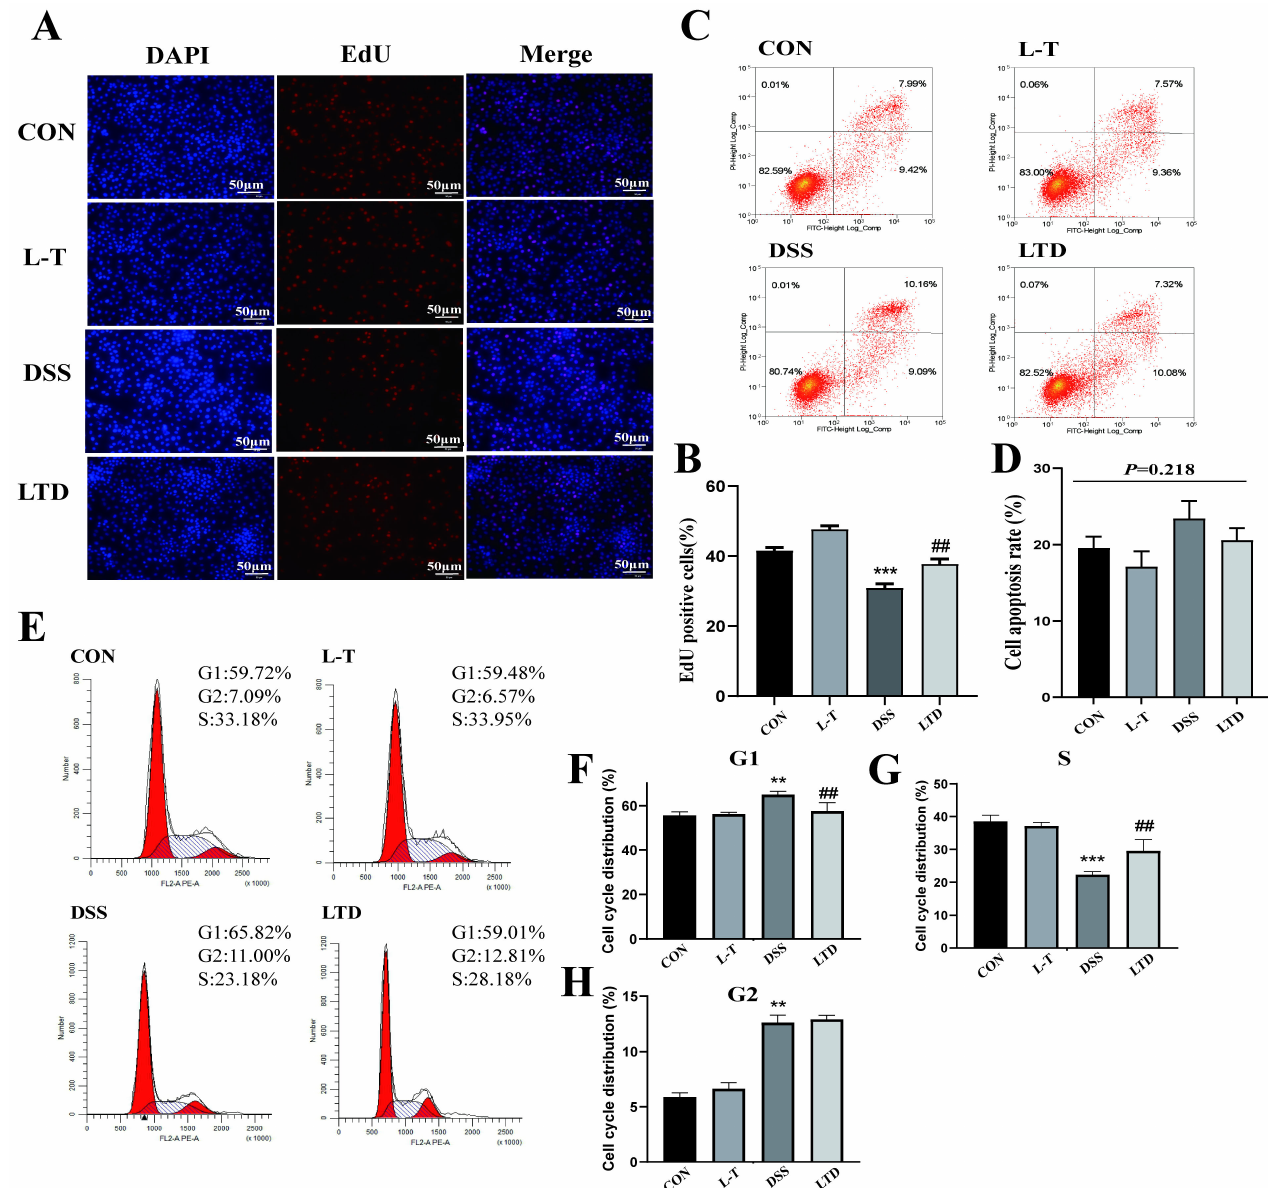
Figure 2. Effect of L-theanine on the proliferation and apoptosis of IPEC-J2 cells induced by DSS. ( A , B ) Representative images of EdU staining of IPEC-J2 cells and results of the analysis of EdU-positive cells ( n = 4) treated with DSS and L-theanine. Scale bar = 50 µ m. ( C , D ) Results of cell apoptosis in four groups analyzed by FACSCanto II flow cytometer ( n = 4). ( E – H ) G1, DNA-presynthetic phase; G2, DNA-postsynthetic phase; S, DNA-synthesis phase. Results of cell cycle in four groups analyzed by FACSCanto II flow cytometer ( n = 4). ** P < 0.01 and *** P < 0.001, compared with the CON group. ## P < 0.01 versus DSS